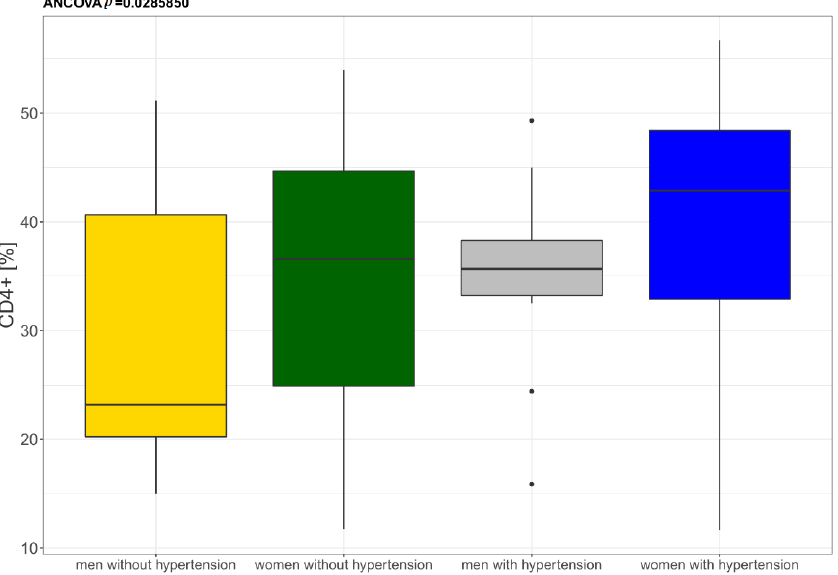
Figure 3. Differentiation of the percentage of total CD4 + in women and men diagnosed with hypertension ( n = 51) and without hypertension ( n = 48).